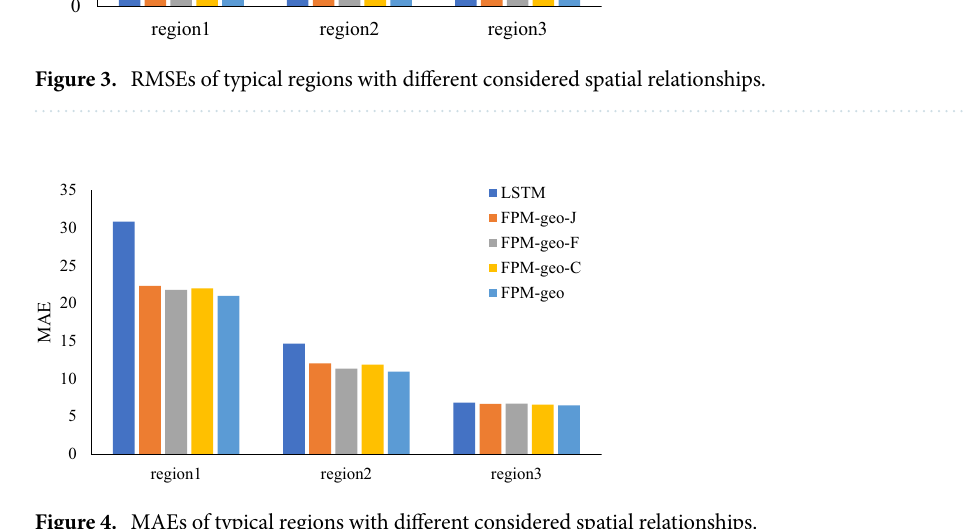
Figure 4. MAEs of typical regions with different considered spatial